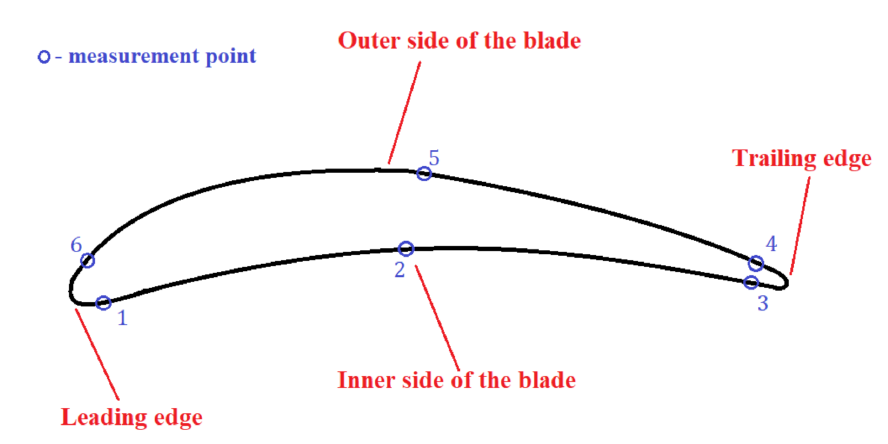
Figure 6. Location of residual stress measurement points along with the blade profile. Table 2. Results of the residual stress in the cross-section located 3 mm above the blade root. - Inner (Concave) Side of the Blade Outer (Convex) Side of the Blade Measurement point 1 2 3 4 5 6 Residual stress σ res , MPa − 478 − 659 − 255 − 197 − 230 −